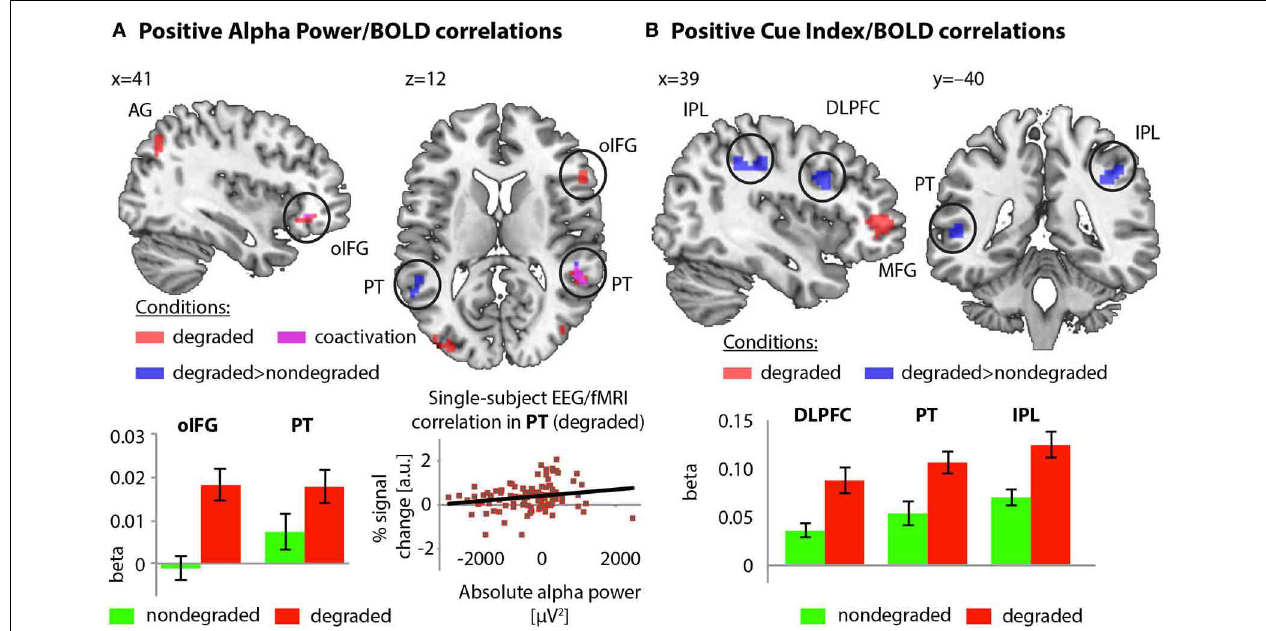
FIGURE 4 | (A) Positive correlation of alpha power with BOLD activity in the degraded condition (red), and correlation differences between conditions (blue; co-activation: magenta). Betas extracted from orbital inferior frontal gyrus and PT ROI visualize correlation differences between conditions. Data taken from a representative participant illustrate the positive single-subject